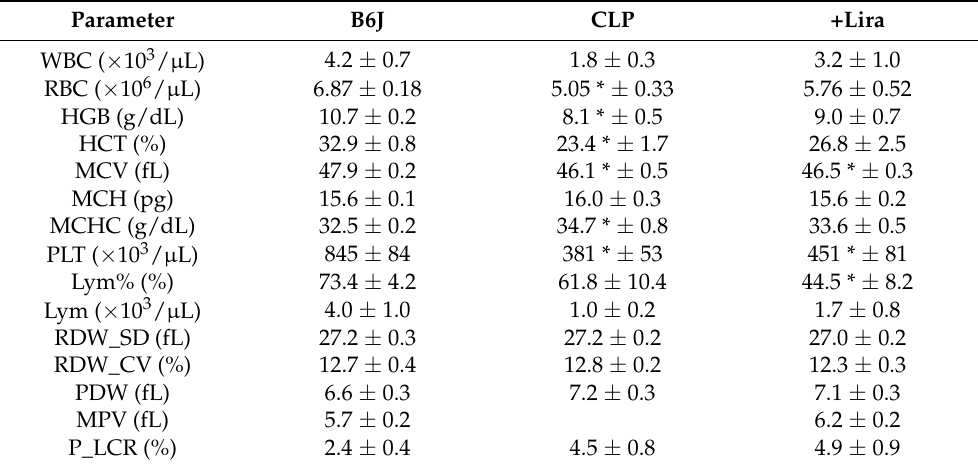
Abbreviations: WBC, white blood cells; RBC, red blood cells; HBG, hemoglobin; HCT, hematocrit; MCV, mean corpuscular volume; MCH, mean corpuscular hemoglobin; MCHC, mean corpuscular hemoglobin concentration; PLT, platelet count; Lym%, percentage of lymphocytes; Lym, lymphocytes; RDW_SD, red cell distribution width—standard deviation, RDW_CV, red cell distribution width—coefficient of variation; PDW, platelet volume distribution width; MPV, mean platelet volume; P_LCR, platelet larger cell ratio.